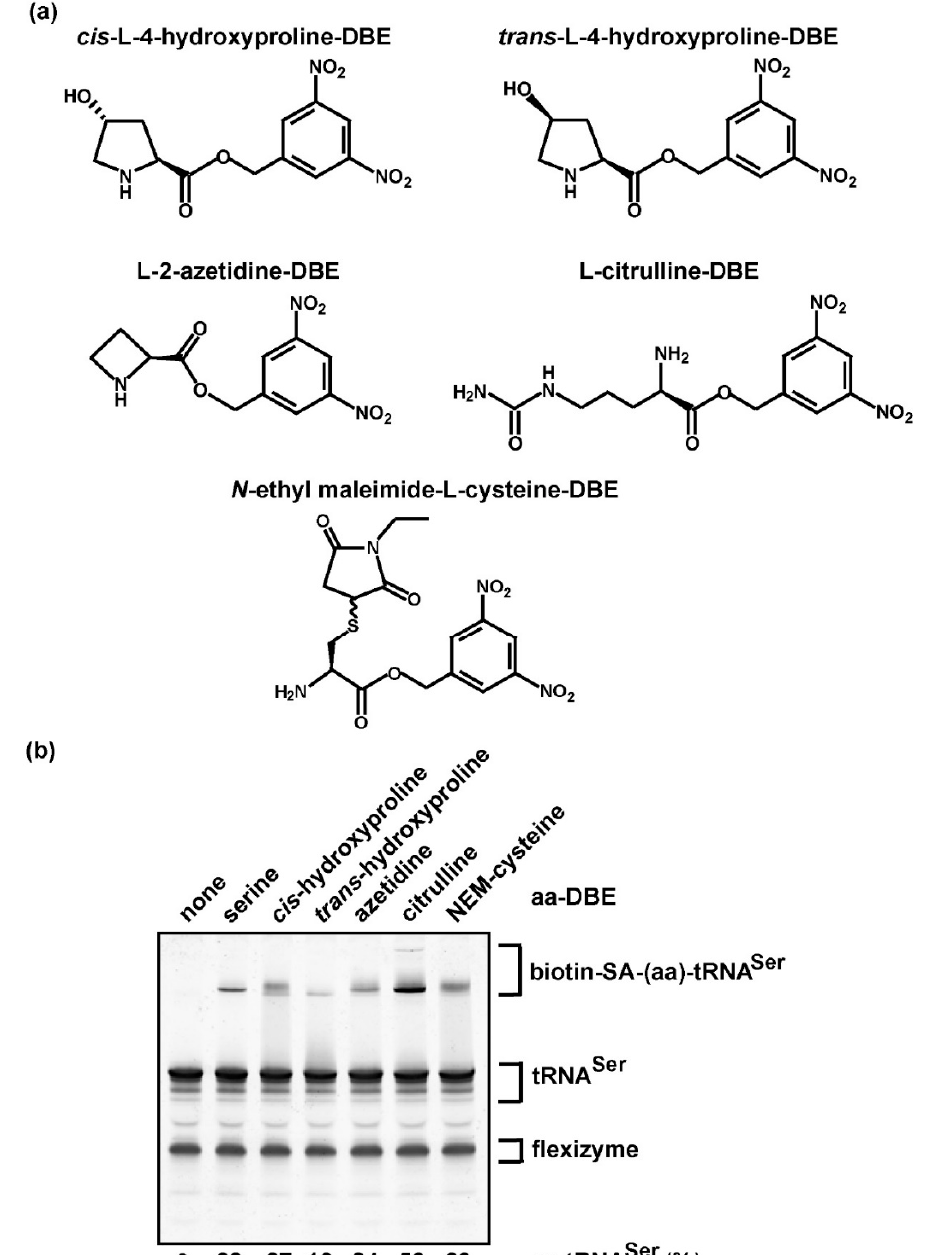
Figure 3. Aminoacylation with non-proteinogenic amino acids as quantified by biotin-SA conjugation. ( a ) Chemical structure of each non-proteinogenic aminoacyl-DBE used for the dFx flexizyme-catalyzed aminoacylation to the transcript of E. coli tRNA Ser / GCU . ( b ) Gel separation and quantification of the aa-tRNA product by biotin-SA conjugation. The % of aminoacylation in each reaction was calculated by adding up all of the upshifted bands relative to the input tRNA and by subtracting the % in the background observed in the control reaction run in parallel but lacking aminoacylation (in lane